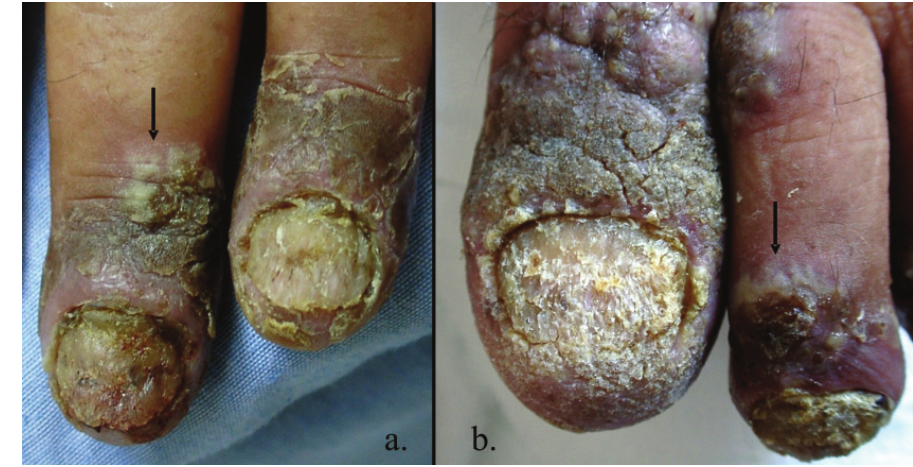
Figure 3 - a. verrucous paronychia with dystrophic finger nail b. similar aspect of the halux. Note the rest of some flacid bullae (arrows)